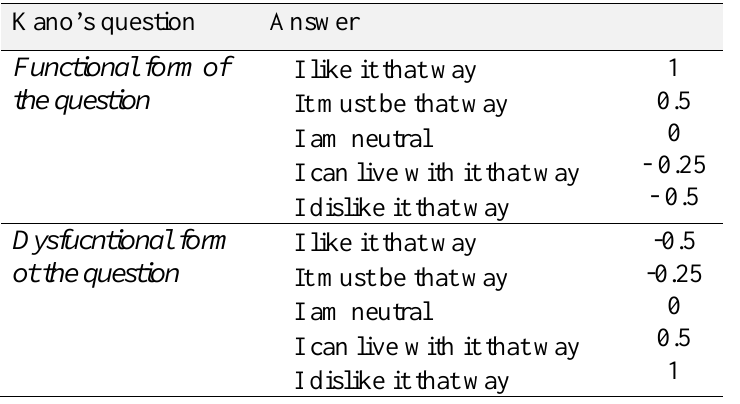
Table 1 – Kano’s questionnaire (Xu et al.,